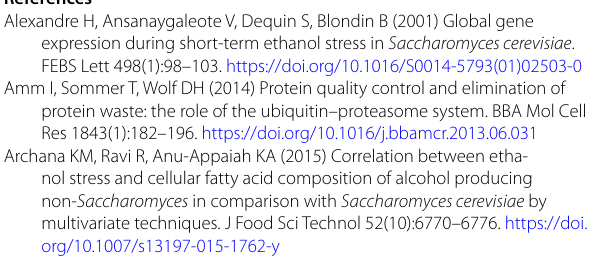
Additional file 2: Figure S1. Protein–Protein Interaction